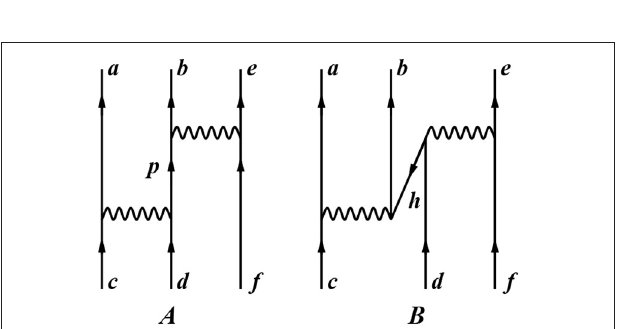
FIGURE 7 | An example of a one-body diagram (see text for details).